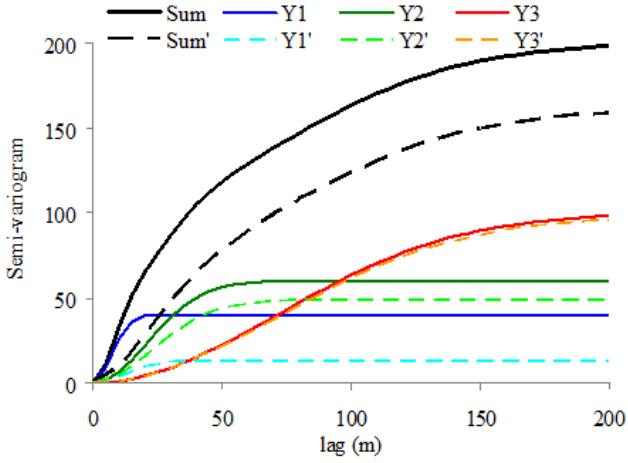
Figure A1. Indication of effects of upscaling on semi-variogram components.